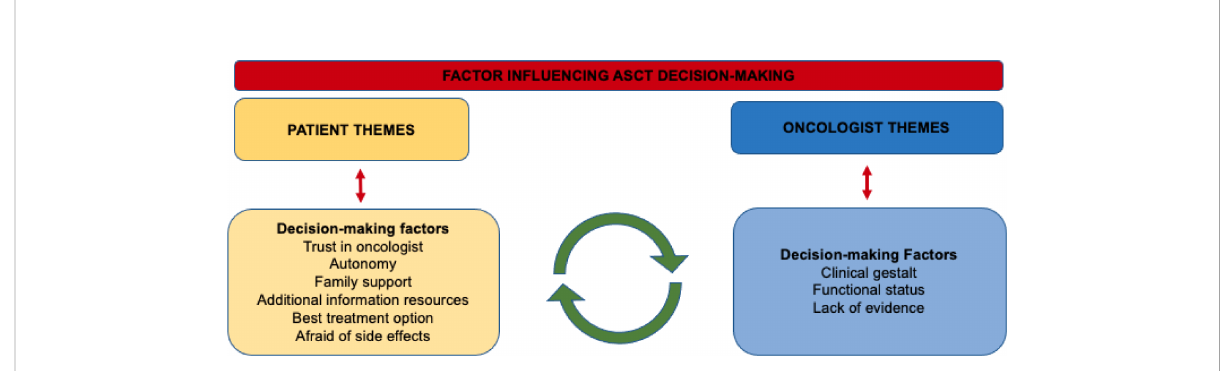
FIGURE 2 Common themes present in semi-structed interviews in fl uencing autologous stem cell transplant decision-making among older adults with multiple